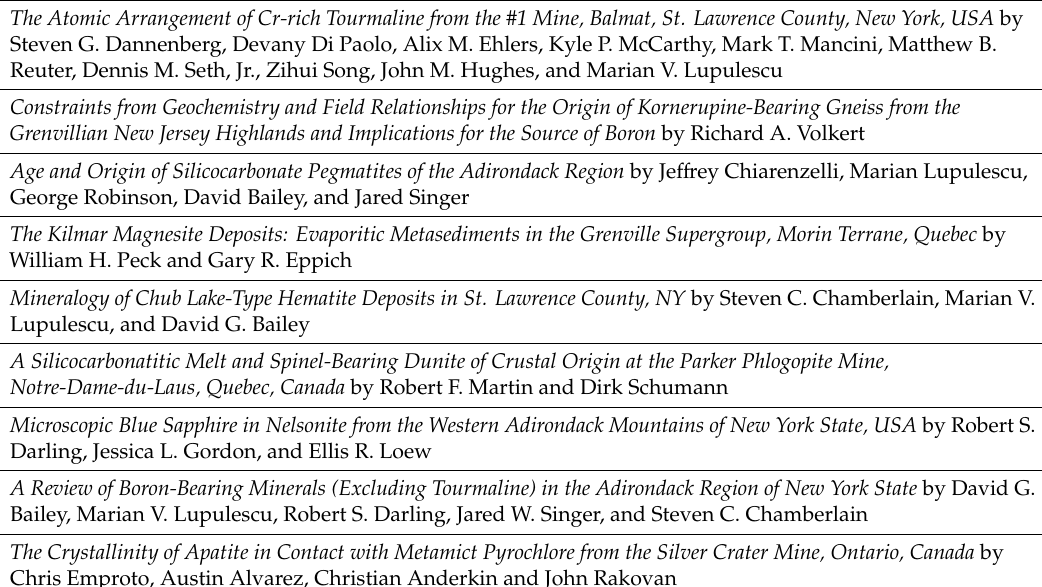
Table 1. List of papers—Minerals of the Southern Grenville